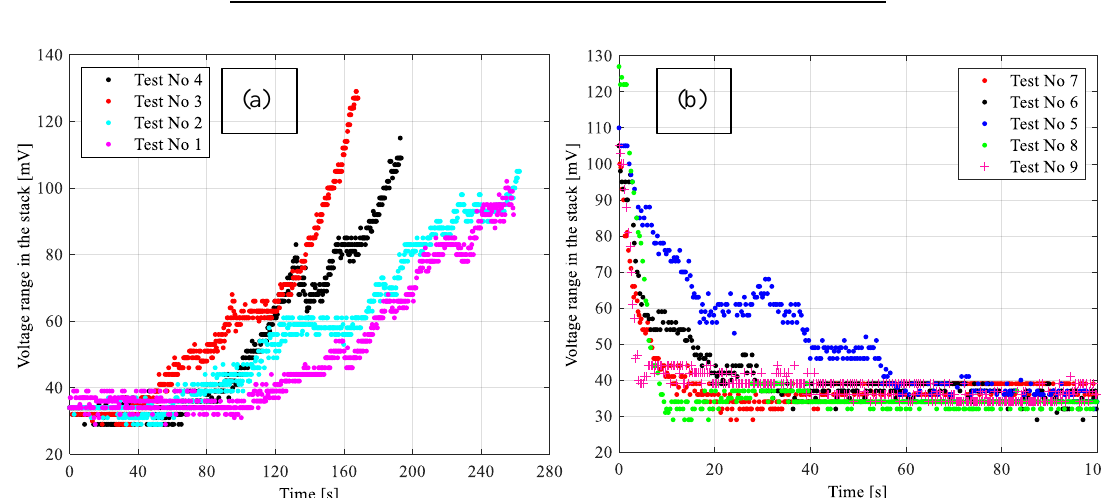
Figure 5. Voltage range in the stack during step changes of the cathode stoichiometry; ( a ) step decrease in cathode stoichiometry, ( b ) step increase in cathode stoichiometry. Table 3. Parameters of the fuel cell system used for identification of voltage range model.